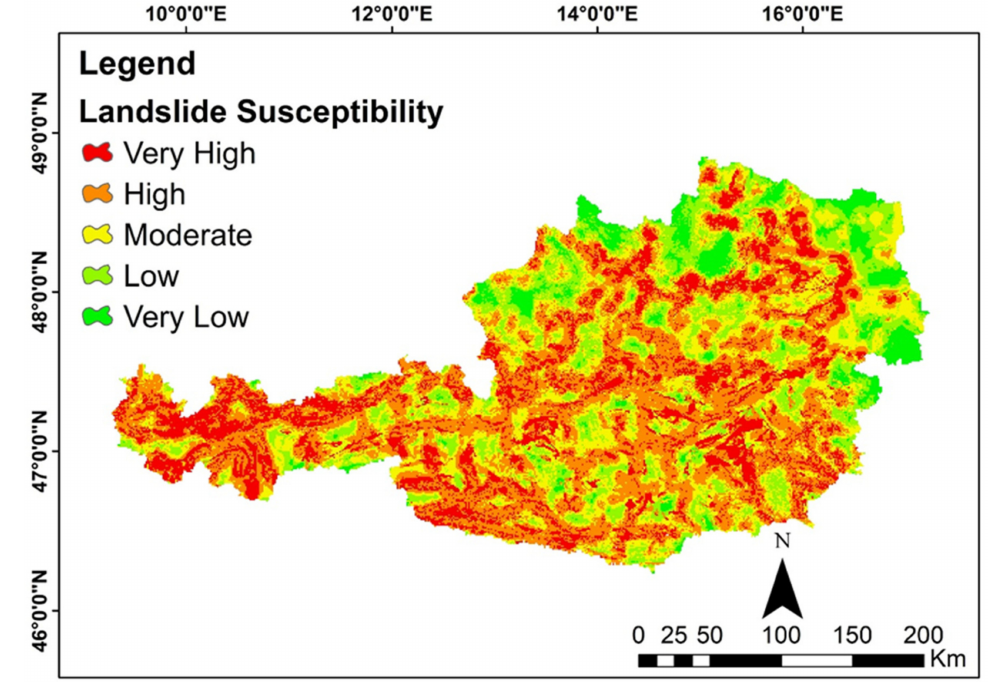
Figure 5. Land susceptibility map for Austria using FAHP